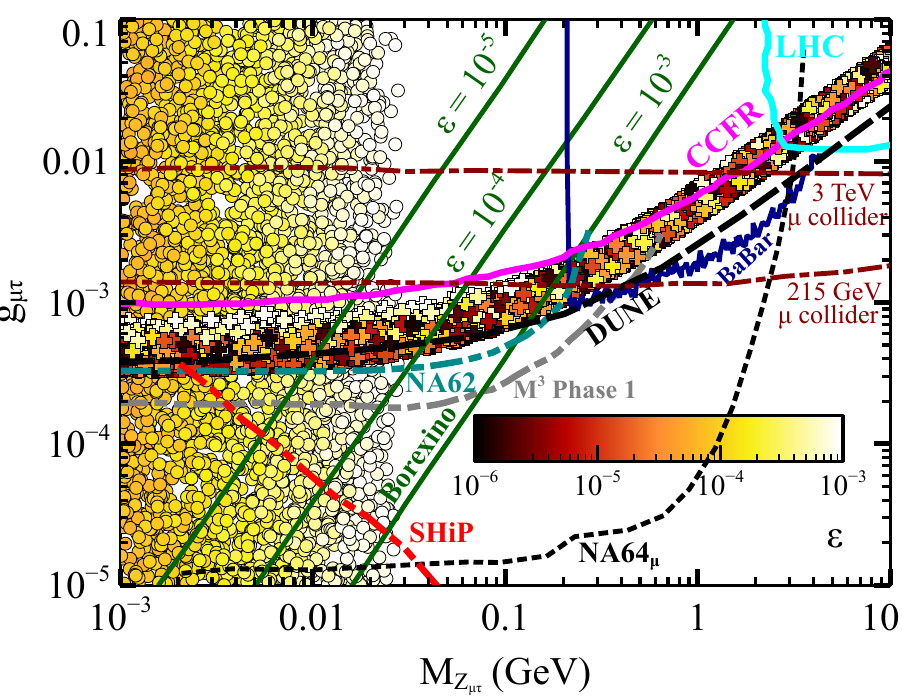
Figure 2 . Parameter space for ( g − 2) e (circular points) and ( g − 2) µ (plus shaped points) with relevant experimental constraints in g plane. Solid lines represent existing bounds while µτ − M Z µτ other lines are projected exclusion limits from future